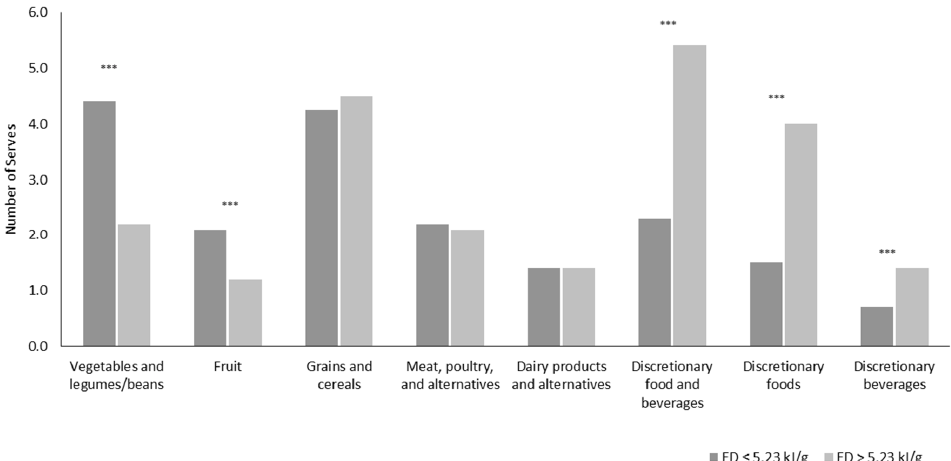
Figure 2. Mean food group intake for Australian young adults (aged 18–34 years) reporting low dietary energy-density ( ≤ 5.23 kJ/g) compared to those reporting higher dietary energy-density (>5.23 kJ/g). One serve = 75 g of vegetables; 125 mL of juice, 150 g of fresh or 30 g dried fruit; 500 kJ of grains and cereals; 500–600 kJ of meat, poultry, and alternatives; 500–600 kJ of milk, yoghurt, cheese, and alternatives; 7 g of polyunsaturated oil or 10 g of polyunsaturated spread/nuts/nut spread and 600 kJ of discretionary foods. *** p < 0.001. Means are adjusted for low-energy reporters (energy intake: basal metabolic rate ratio of <0.87). Survey-specific weighting factors were applied.